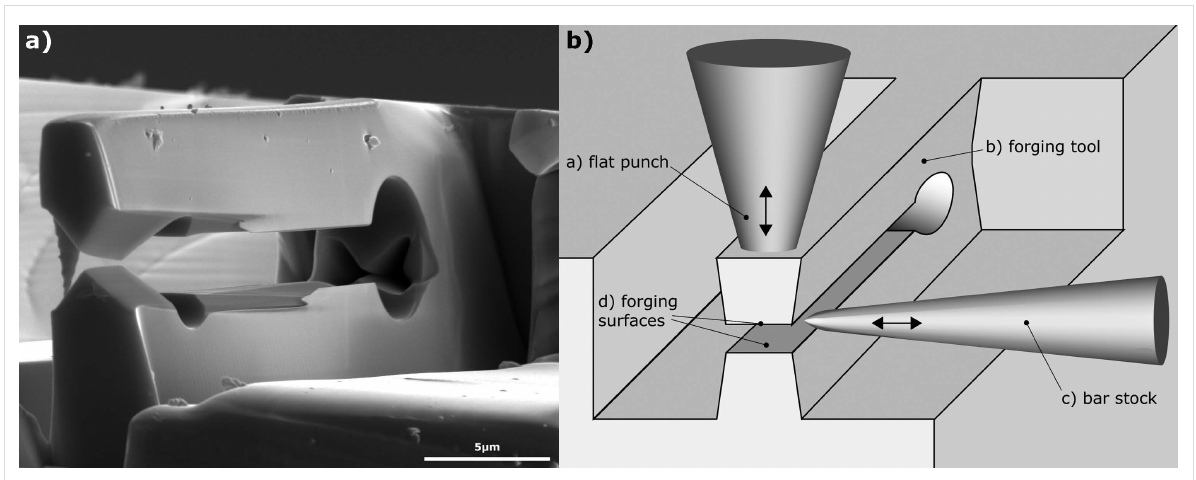
Figure 2: Spring principle of a cutting tool on the left (a). Installation schematically on the right (b). The upper bending arm of the forging tool moves down when pressing on it with the flat punch. It moves in its initial position while load release due to the elastic force. The bar stock is moved between the forging